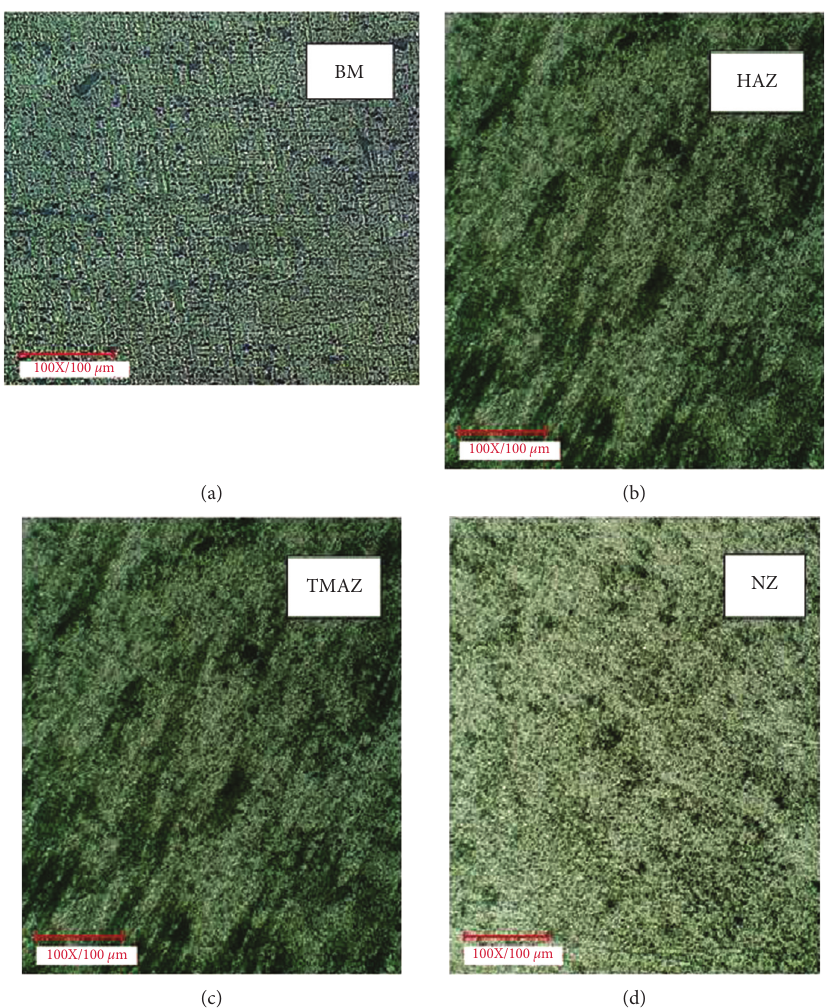
Figure 10: (a) Microstructure of the base metal of AA5052 and (b–d) cross section of the bead-on-plate processed specimen at a tool spinning speed of 1000rpm, traverse speed of 20mm/min, and axial load of 5kN.